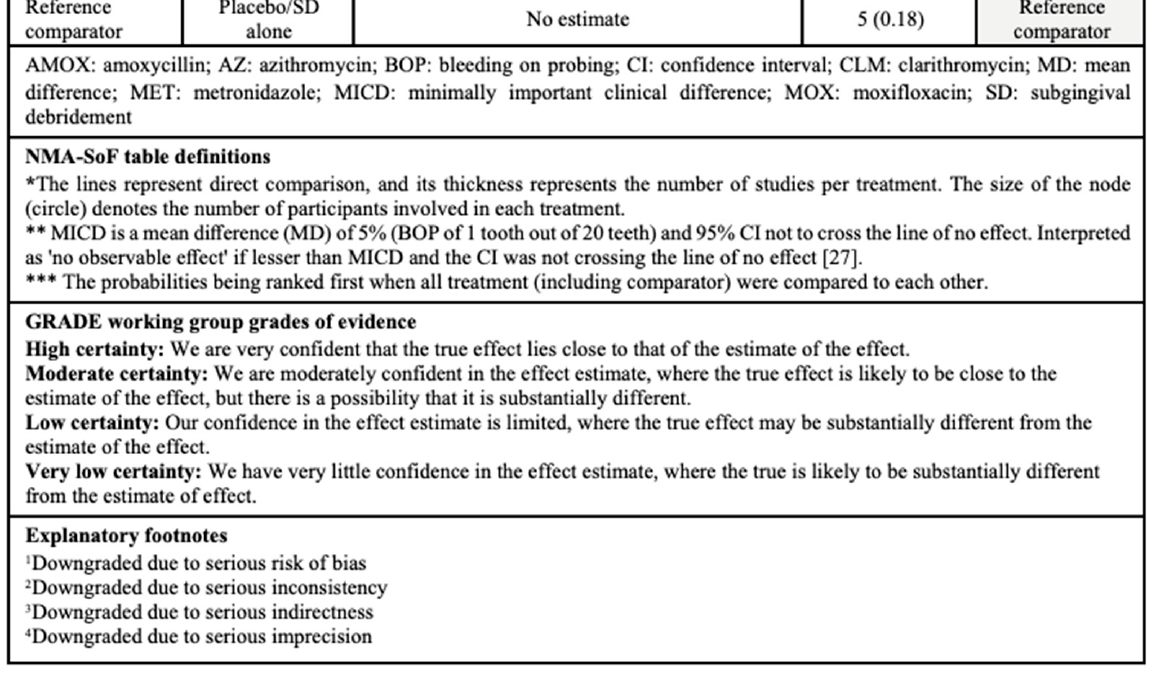
Figure 13. Summary of findings for intermediate-term BOP reduction following the use of systemic antibiotics adjunctive to subgingival debridement.